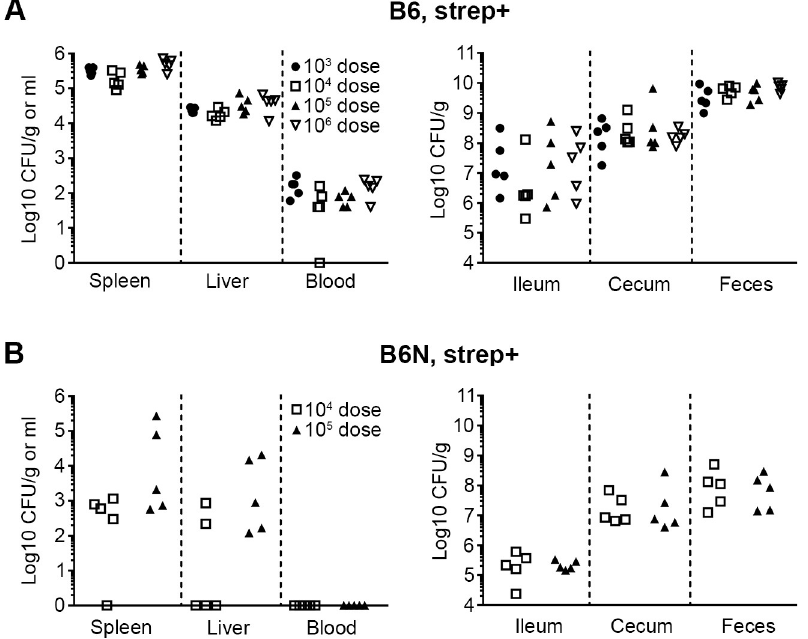
Fig 3. Colonization of B6 and B6N mice following VC inoculation. (A) Bacterial loads in tissues 3 days p.i. in strep + B6 mice infected with indicated CFUs. (B) Bacterial loads in tissues 3 days p.i. in strep+ B6N mice infected with 10 4 or 10 5 CFUs. n = 5 mice and symbols represent individual mice. Tissues where bacterial load was below the level of detection are given a value of “1” for visualization purposes.